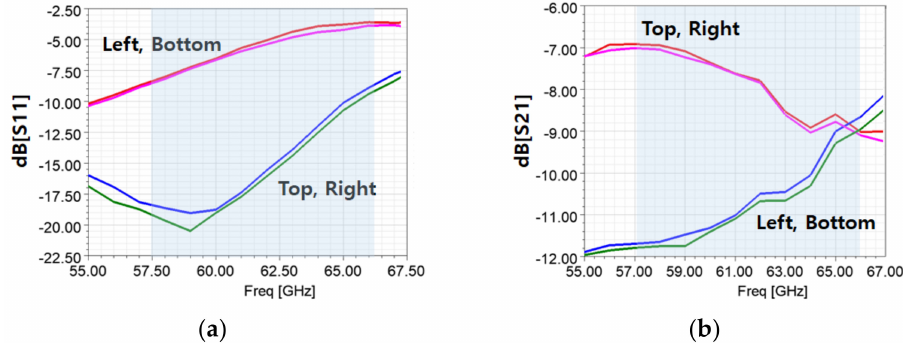
Figure 10. Measurement results of ( a ) return loss and ( b ) insertion loss for the asymmetric 1 × 4